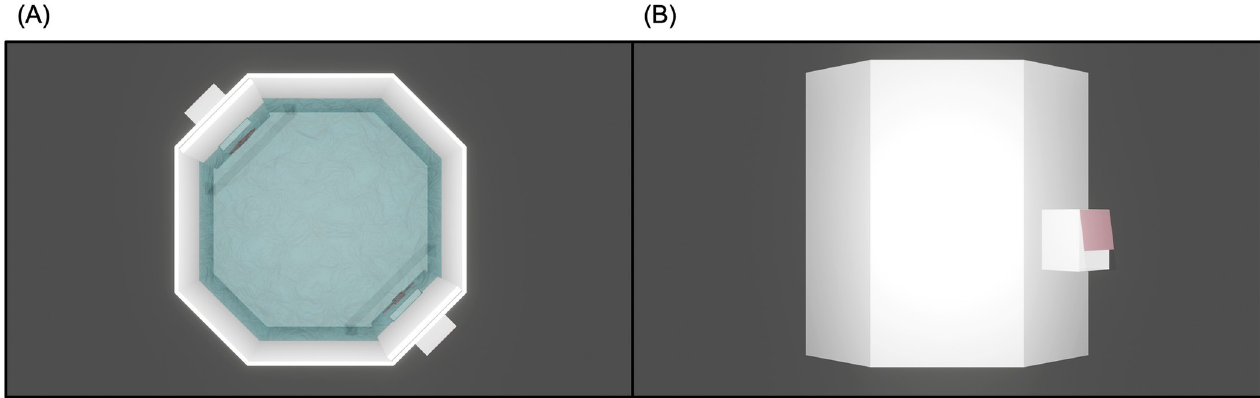
Fig 2. Training arena. In (A), the top view shows: The positioning of the training panels with the stimuli along the arena’s diagonal; the transparent screens ahead of the stimuli; the position of the corridors towards the outside. In (B), the lateral view shows a detail of the open (rewarding) corridor with a flexible door at the end: fish could leave the training arena by swimming through the corridor and slightly pushing the door.